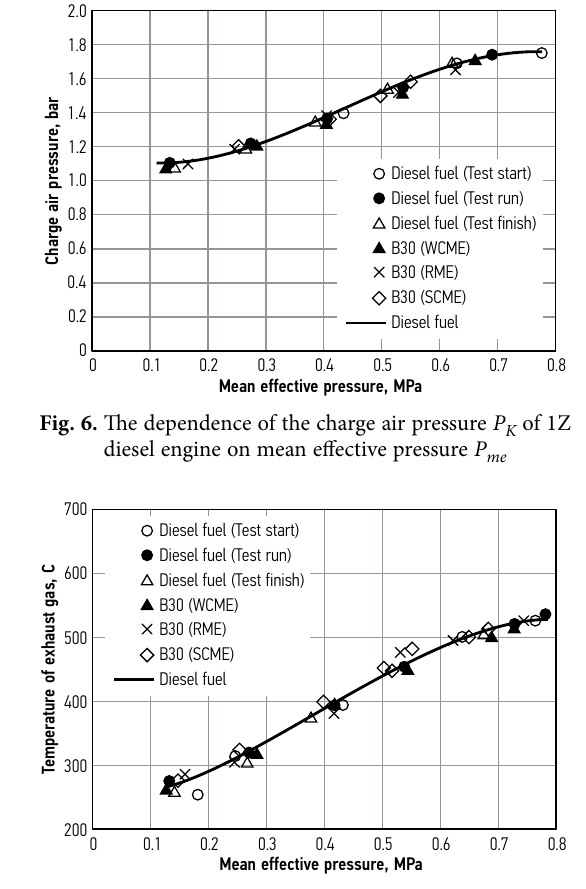
Fig. 10. The dependence of the nitrogen oxides (NO x ) emission of 1Z diesel engine on mean effective pressure P